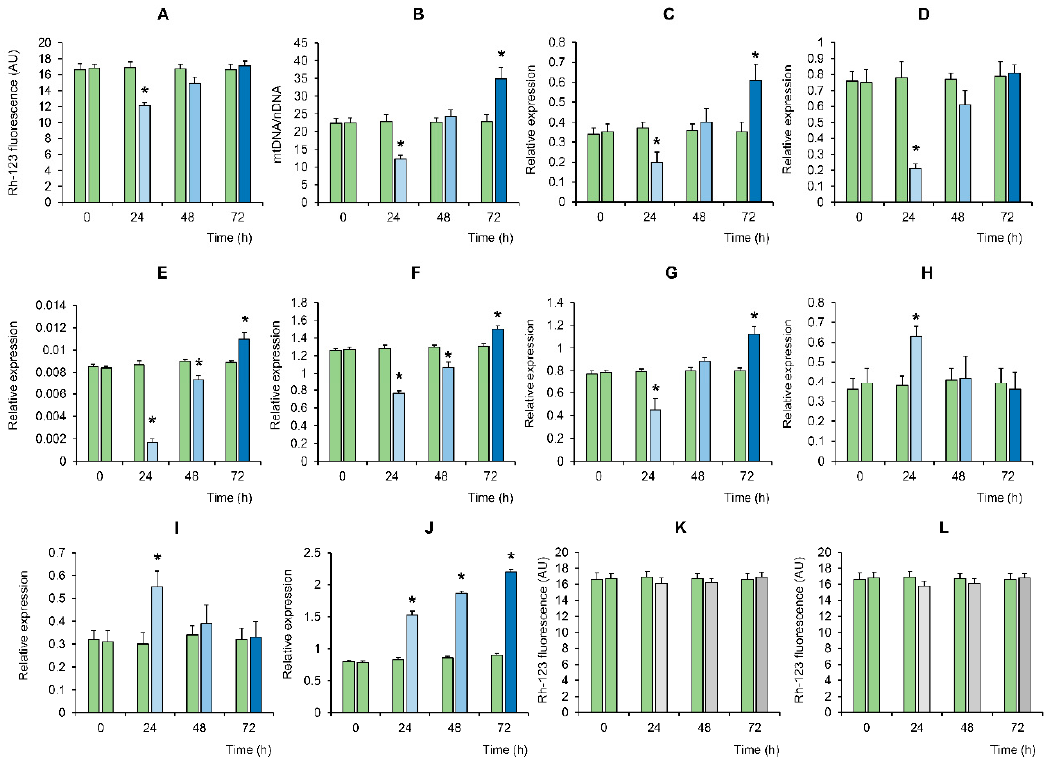
Figure 3. Time-dependent changes in mitochondrial potential, biogenesis and dynamics in the BMSC in response to LTP treatment (blue bars). Panels A and B show the e ff ect of LTP on ( A ) the mitochondrial potential of BMSC, assessed by rhodamine-123 (Rh-123) fluorescence, and ( B ) the ratio of mtDNA to nDNA. A real-time quantitative polymerase chain reaction (qPCR) was carried out to determine the mtDNA copy numbers as a mitochondrial (ND1) to nuclear (globulin) ratio. Panels C–J show the e ff ect of LTP on the relative expression (to β -actin (bAct) of the following genes: ( C ) PGC-1a; ( D ) DRP1; ( E ) OPA1; ( F ) MFN1; ( G ) MFN2; ( H ) PINK1; ( I ) Parkin; and ( J ) FIS1. Panels ( L , K ) show the e ff ect of hydrogen peroxide (50 and 100 µ M, respectively) on the mitochondrial potential of the BMSC in the absence of LTP treatment (grey bars). The green bars indicate no exposure to plasma. The values are given as means ± SEM ( n = 3). * p < 0.05 compared to the control.